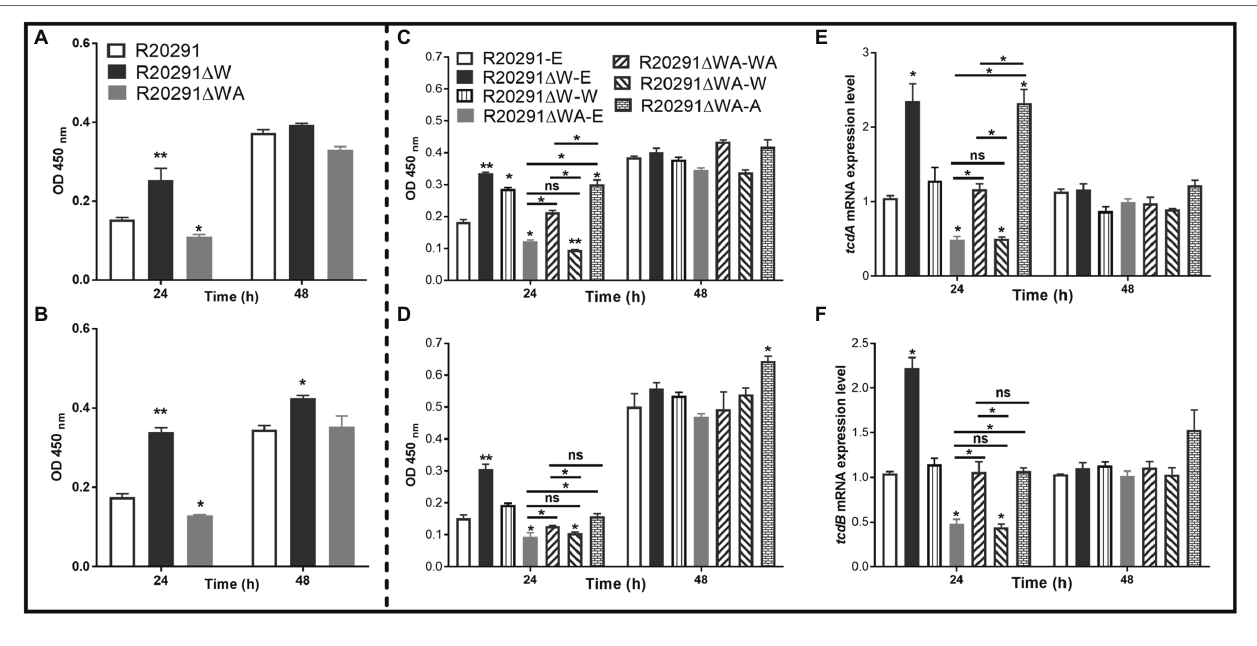
FIGURE 5 | Toxin expression analysis. (A) TcdA concentration in the supernatants of R20291, R20291 ∆ WA, and R20291 ∆ W. (B) TcdB concentration in the supernatants of R20291, R20291 ∆ WA, and R20291 ∆ W. (C) TcdA concentration in the supernatants of parental and gene complementation strains. (D) TcdB concentration in the supernatants of parental and gene complementation strains. (E) Transcription of tcdA in the supernatants of parental and gene complementation strains. (F) Transcription of tcdB in the supernatants of parental and gene complementation strains. Experiments were independently repeated thrice. Bars stand for mean ± SEM (* p < 0.05, ** p < 0.01). One-way ANOVA with post hoc Tukey test was used for statistical significance. ** upon the column directly means the significant difference of experimental strain compared to R20291 or R20291-E.